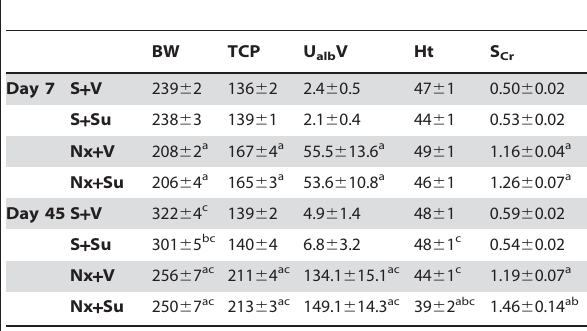
Mean 6 1 SE; BW: body weight, grams; TCP: tail-cuff pressure, mmHg; U alb V: daily urinary albumin excretion rate, mg/24 h; Ht, arterial hematocrit, %; S Cr : serum creatinine concentration, mg/dL. a p , 0.05 vs. respective S; b p , 0.05 vs. respective untreated; c p , 0.05 vs. respective value on Day 7.